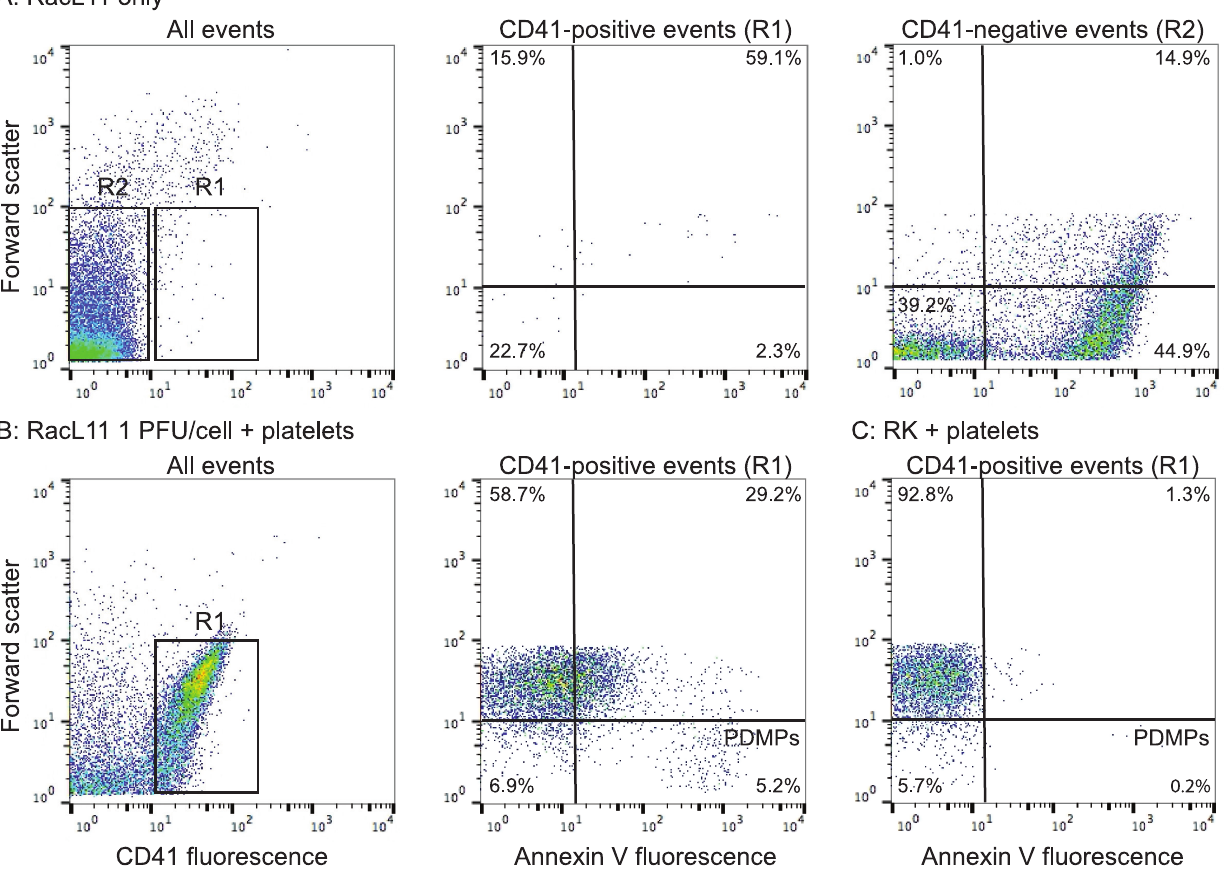
Fig 2. Revised flow cytometry gating strategy for quantification of platelet-derived microparticles in equine platelet samples. A : Non-virus events in samples containing virus only (RacL11 shown) were identified and gated as CD41-positive events (R1 region) in a CD41 fluorescence versus forward scatter dotplot. Virus events were defined as CD41-negative events (R2, left panel). Large numbers of events ( > 100,000) were counted in the virus alone sample to optimize establishment of the gate. Quadrant regions of an Annexin V fluorescence versus forward scatter plot showed few Annexin V-positive events (middle panel, R1 gate), whereas many (57%) of the CD41-negative virus events were positive for Annexin V, with about 80% being small events ( < 101 log forward scatter units, right panel, R2 gate). B : Representative images of platelets in citrated platelet-rich plasma exposed to the RacL11 strain of EHV-1 at 1 plaque forming unit (PFU)/cell. Platelet-derived microparticles (PDMPs) were defined as small events ( < 101 log forward scatter units) that were double positive for CD41 and Annexin V. CD41-positive events were first defined as above (R1 gate, left panel), then the PDMP percentage was obtained from the lower right quadrant of an Annexin V fluorescence dotplot of the R1 gate, with positive fluorescence for Annexin V being defined on a sample with no added Annexin V. In this sample, there are 8.7% PDMPs. The events in the upper left and right quadrants are platelets that are negative (58%) and positive (25%) for Annexin V, respectively. Note, that the Annexin V-positive platelet events (upper right quadrant) could reflect virus bound to platelets (since virus alone binds Annexin V) versus phosphatidylserine exteriorization on the platelet surface. C : Representative image of PDMP quantification in platelets exposed to rabbit kidney (RK) cell lysate at an equivalent volume to 1 PFU/cell (mock-infected control). In this sample, there are 0.1% PDMPs (lower right quadrant) and 1% of platelets are weakly positive for Annexin V (upper right quadrant).